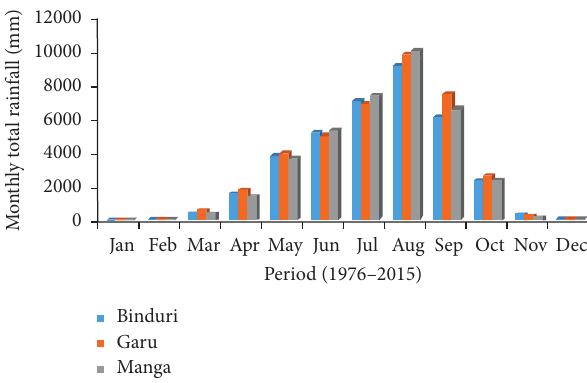
Figure 4: Rainfall monthly cycles in the Bawku Area. Table 5: Mann–Kendall trend test for annual rainfall.